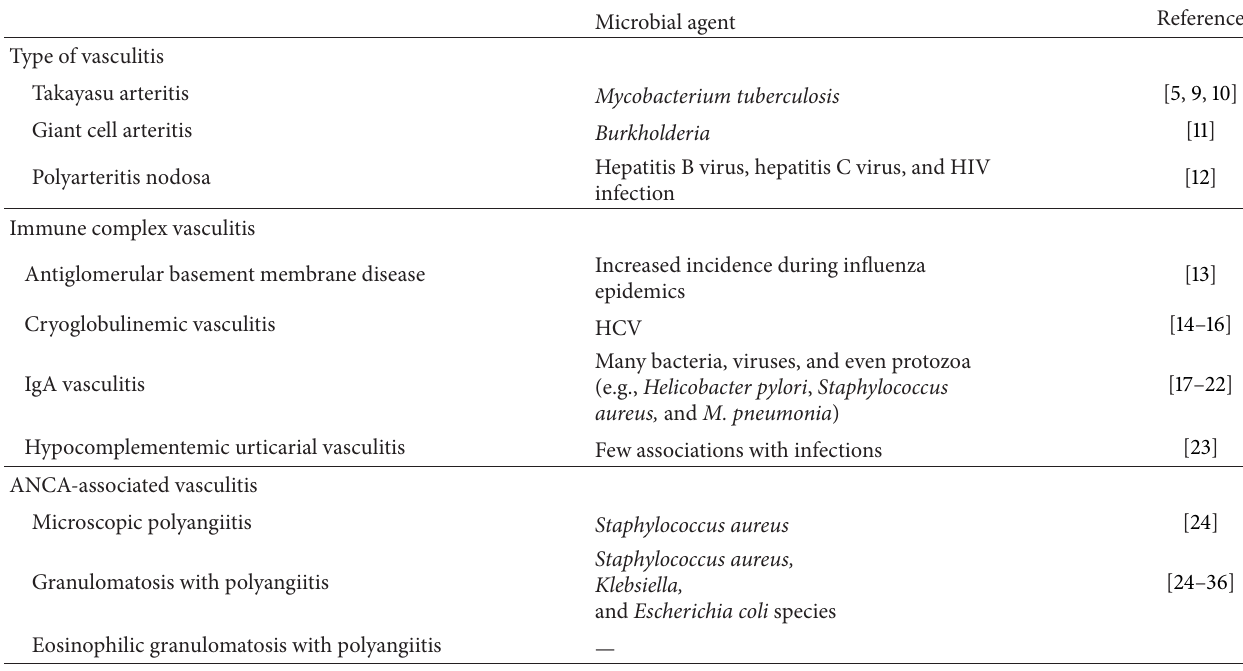
Table 1: The most important microbial agents presumed to be involved in the development of primary systemic